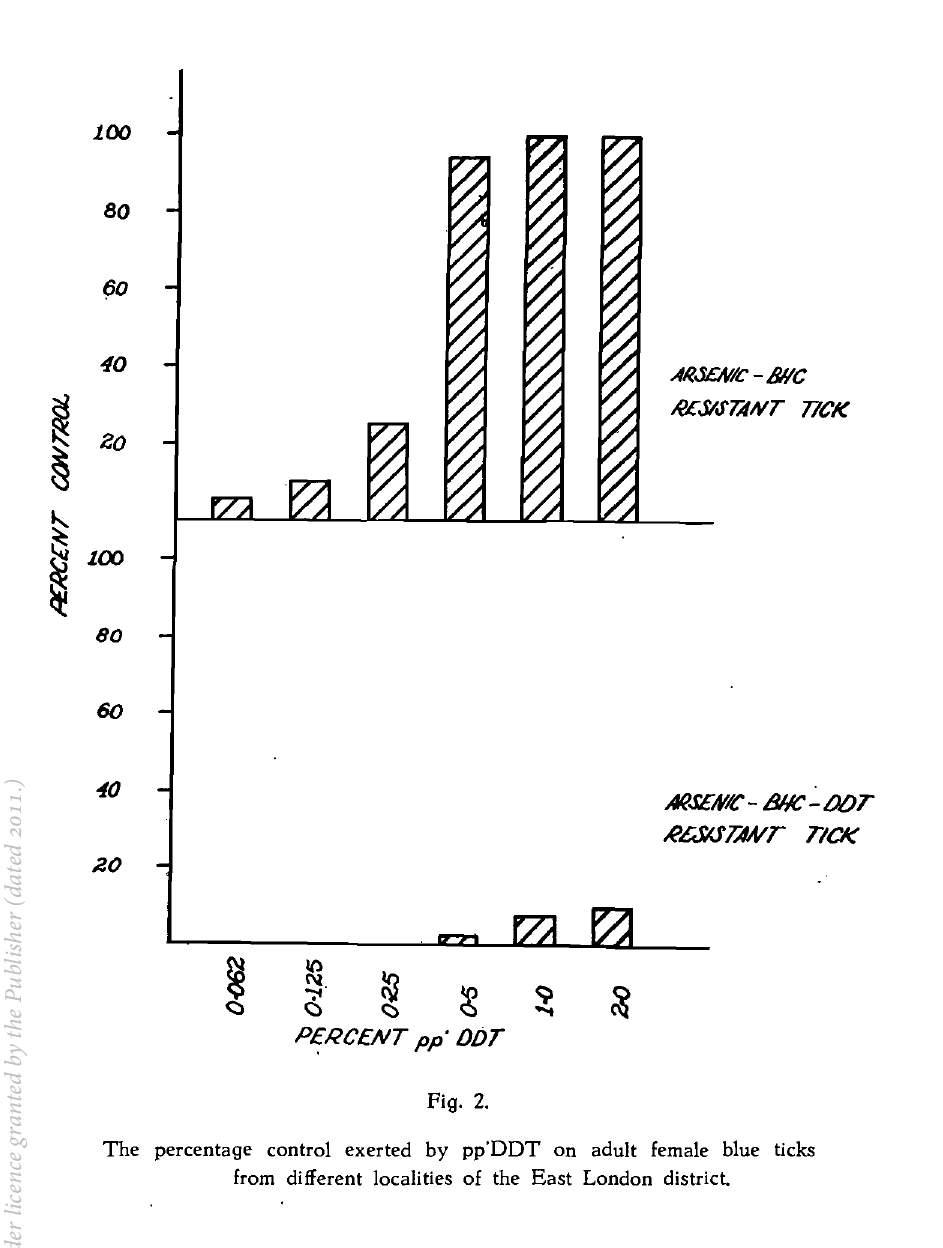
The percentage control exerted by pp'OOT on adult female blue ticks from different localities of the East London